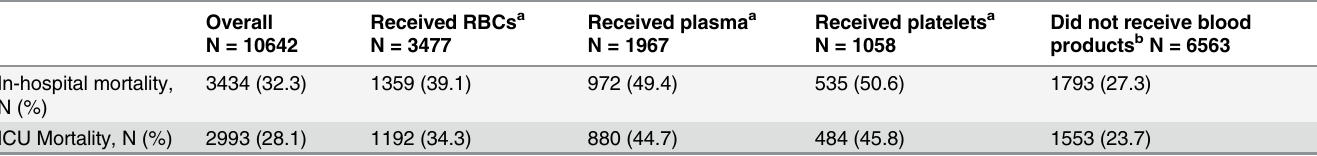
Table 2. In-hospital mortality rates and ICU mortality rates by type of blood product. Overall N = 10642 In-hospital mortality, N